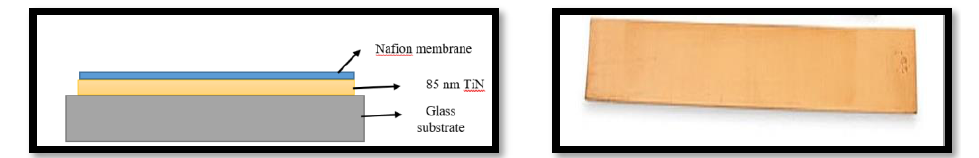
Figure 2. Schematic representation of 85 nm thick TiN electrode with Nafion layer ( left ) and an image of the actual Nafion modified electrode ( right ).